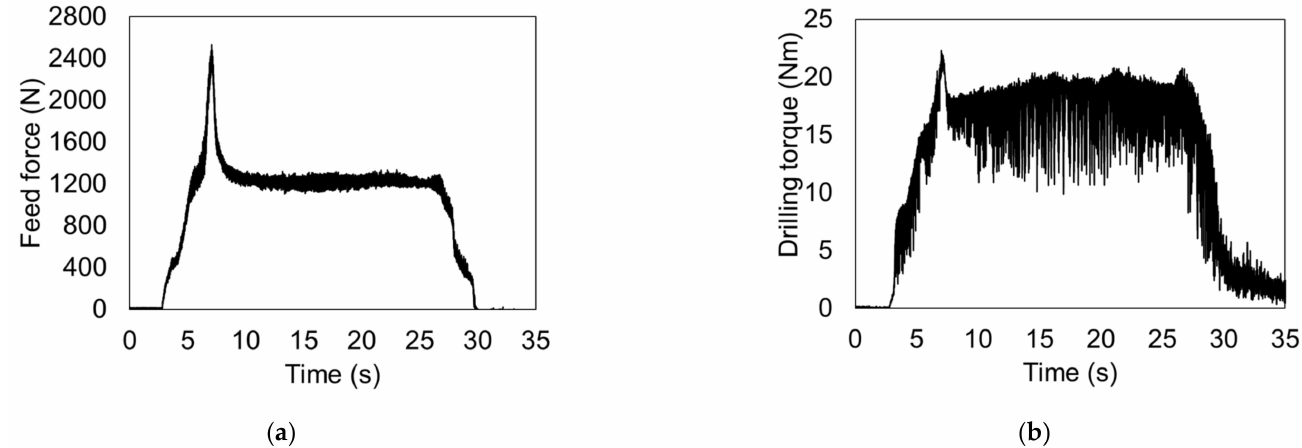
Figure 2. Feed force evolution ( a ) and drilling torque evolution ( b ) measured in an experiment for a cutting depth of 20 mm, a feed of 0.042 mm/rev, and a cutting speed of 68 m/min